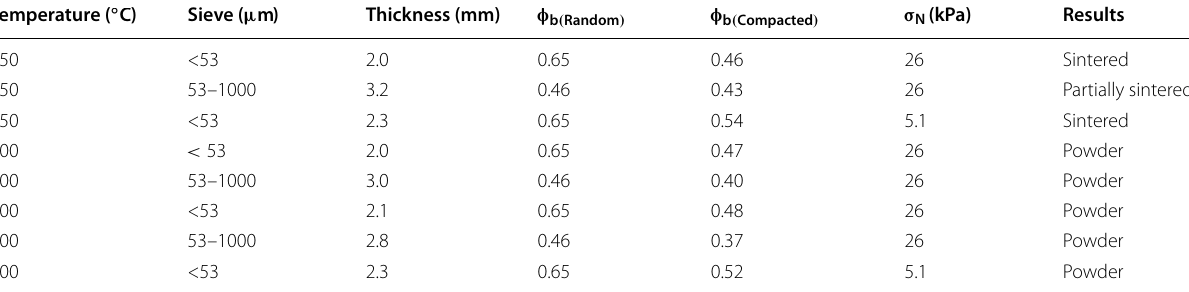
The thickness is the final value of the measurement, and σ N is the desired normal stress to be imposed